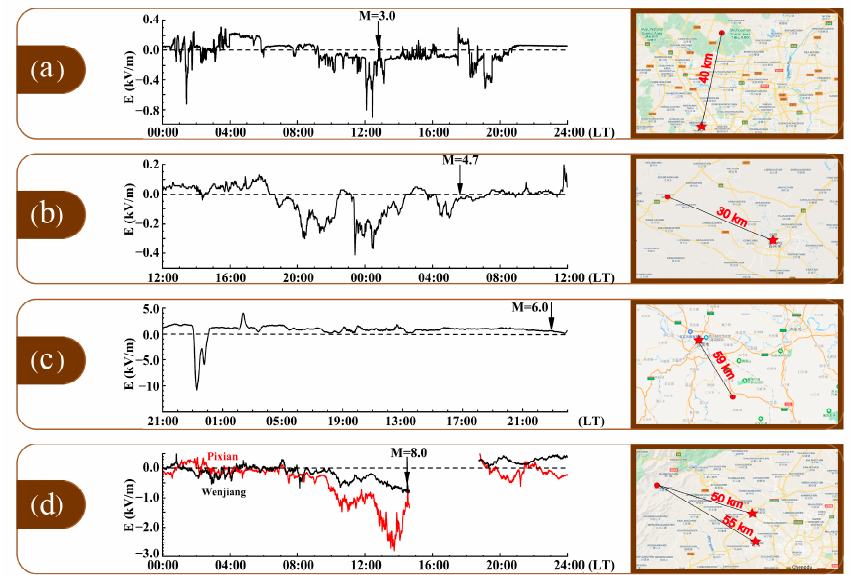
Figure 1. Negative atmospheric electrostatic field Ez before earthquakes. ( a ) Beijing Ms 3.0 earthquake on 14 April 2019, with a station located 40 km from the epicenter. ( b ) Rongxian Ms 4.7 earthquake on 24 February 2019, with a station located 30 km from the epicenter. ( c ) Wenchuan Ms 8.0 earthquake on 12 May 2008, with two stations located 50 and 55 km from the epicenter. ( d ) Changning Ms 6.0 earthquake on 17 June 2019, with a station located 50 km from the epicenter. The data gap in panel ( c ) is due to a power outage. In the maps on the right, the stars denote the stations and the circles denote the epicenters.